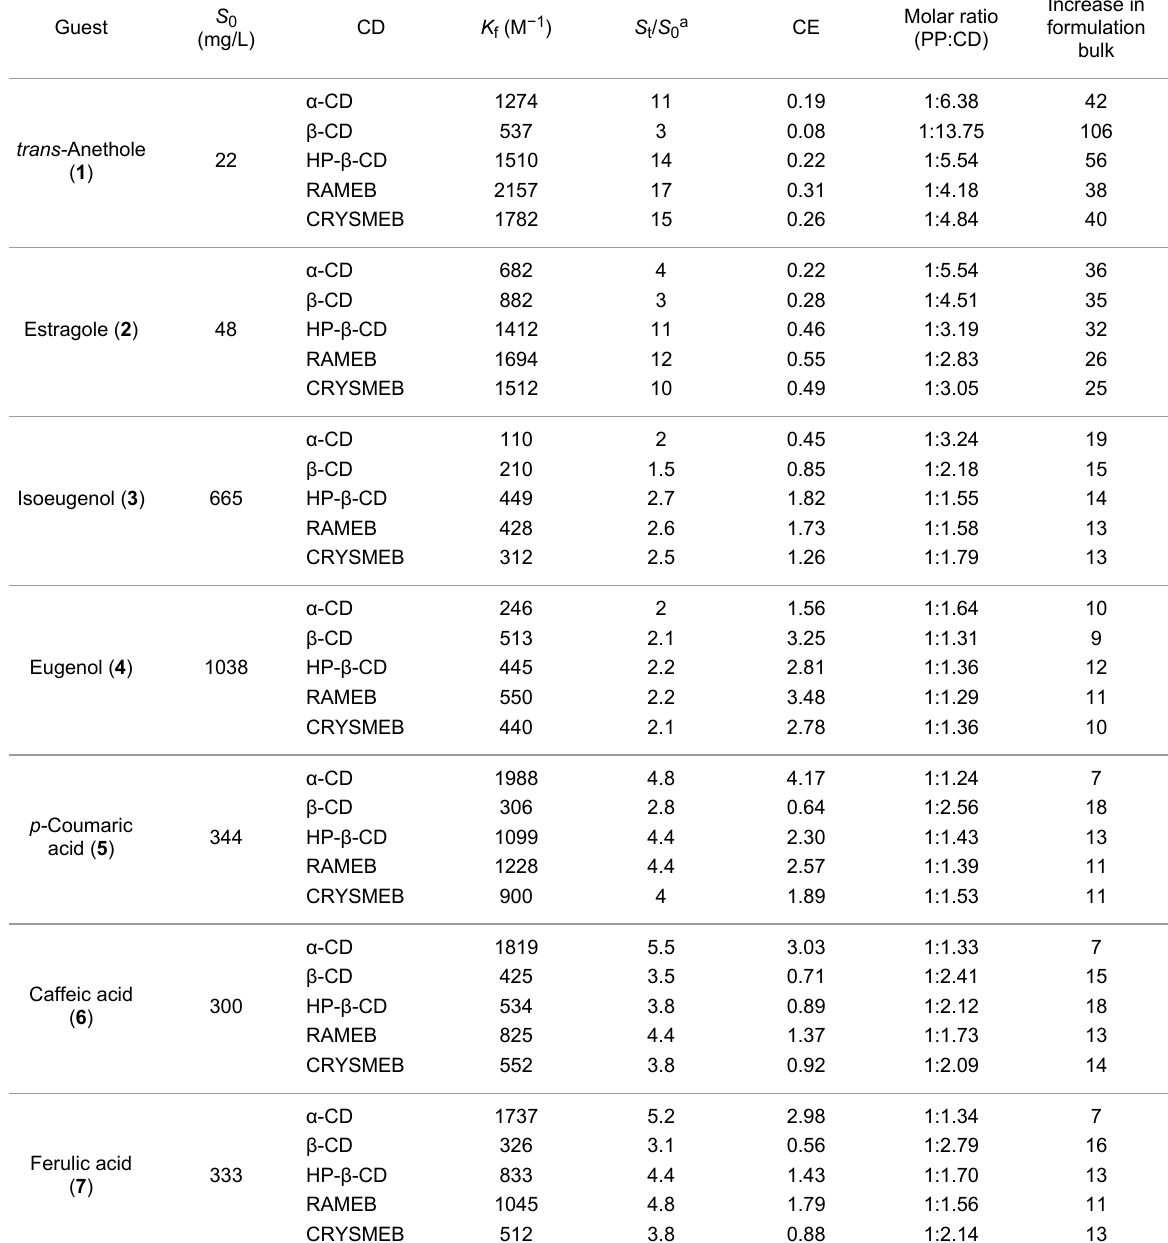
Table 2: Formation constants ( K f ), solubility enhancement ratio S t / S 0 , CE, optimum molar ratio and increase in formulation bulk of phenylpropanoids.